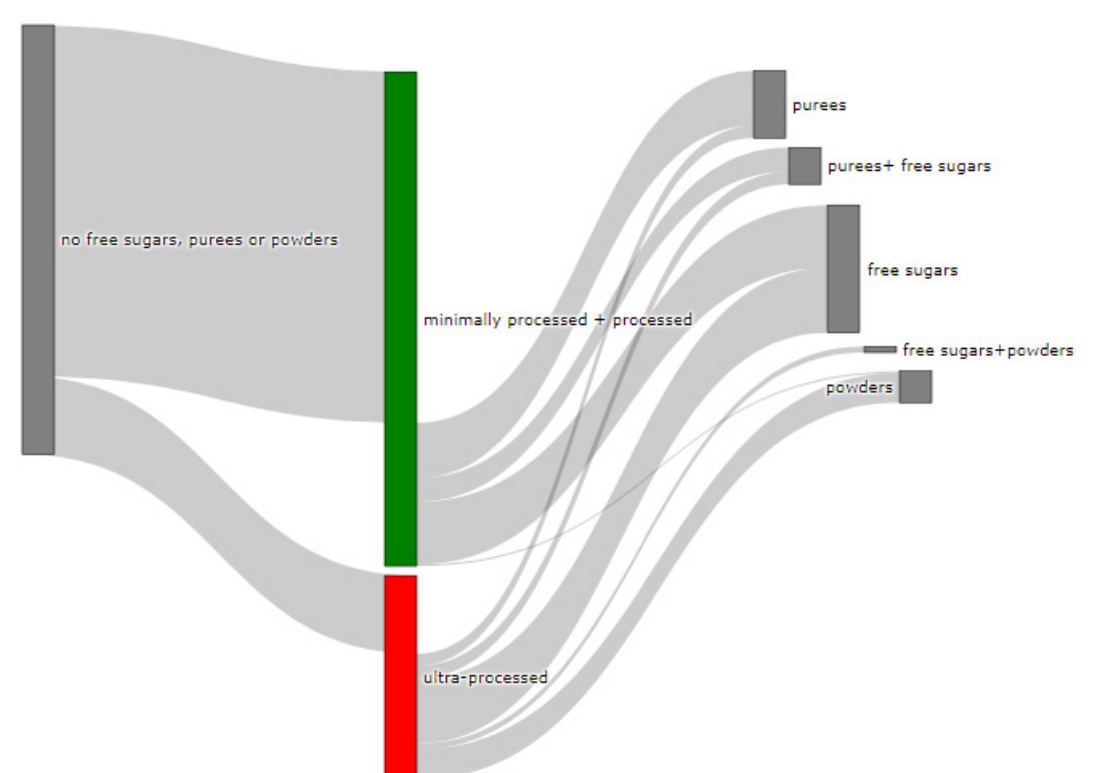
Figure 3. Graphical representation of the proportion of minimally processed/processed foods (green bar, n = 2426) and ultra-processed foods (red bar, n = 1001) that contained free sugars (as defined in [12]), fruit and vegetable purees, and fruit and vegetable powders as an ingredient (to the right) or did not contain any of these sugar-contributing ingredients (to the left). The graph is read starting from the middle (coloured bars). The length of the bars is based on the number of products within each category and indicates the proportion in the total sample.